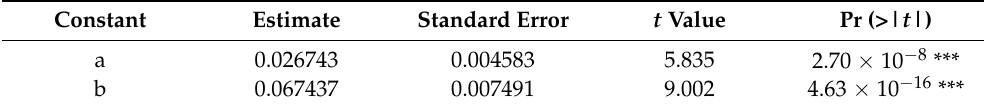
Table 4. Parameters of the exponential model describing the effect of soil temperature on the CO 2 efflux from undisturbed bare soil under field conditions in Karcag, Hungary. Constant